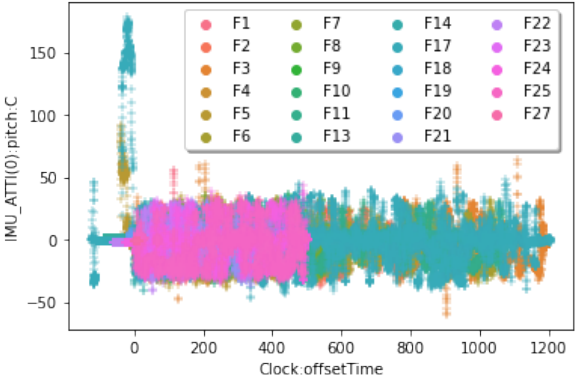
Figure 3. Identifying the flight number with abnormal pitch